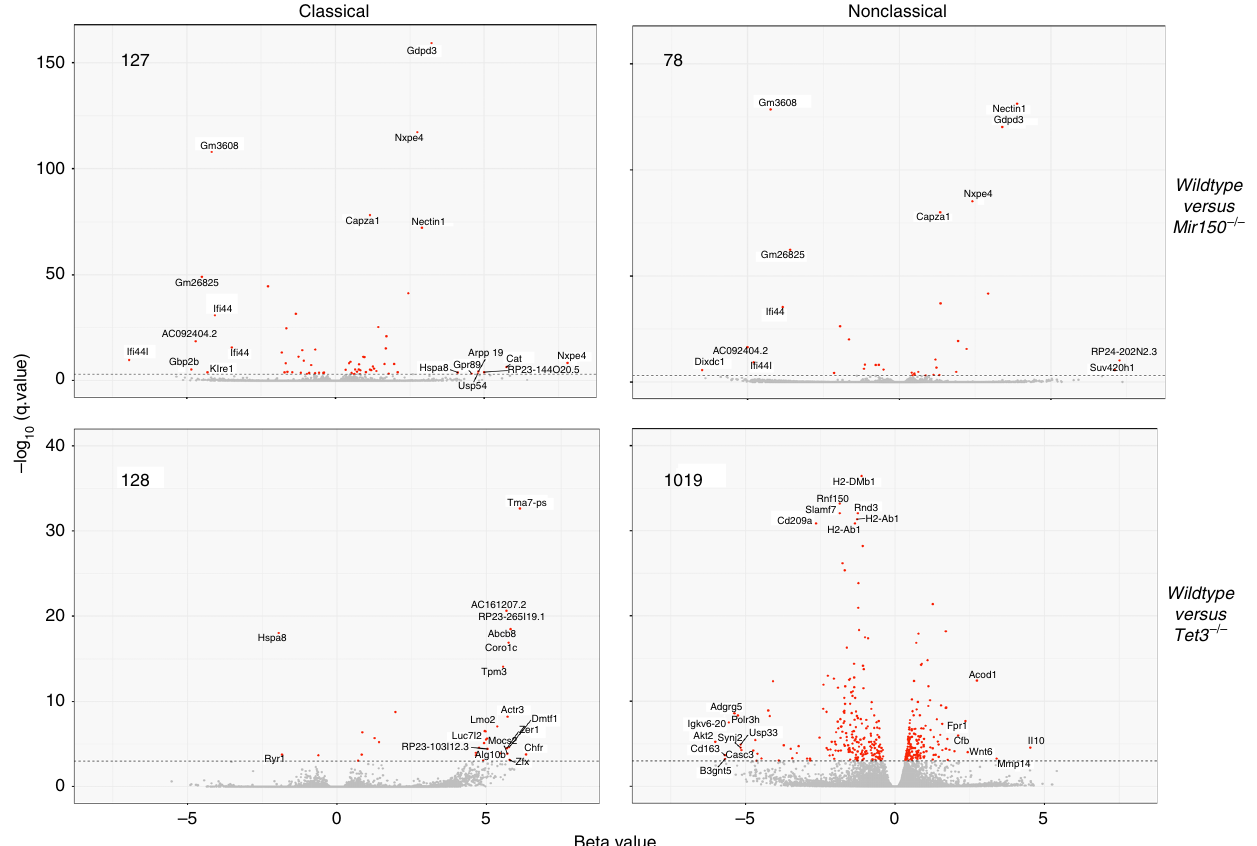
Fig. 9 RNA-sequencing of mouse monocyte subsets. Volcano plot representation of differentially expressed genes in wild-type littermates versus either Mir150 − / − (upper panels) or Tet3 − / − (lower panels) monocytes subtypes. The number of differentially expressed genes (cut-off q value 0.001) is indicated in each panel, as well as the name of differentially deregulated